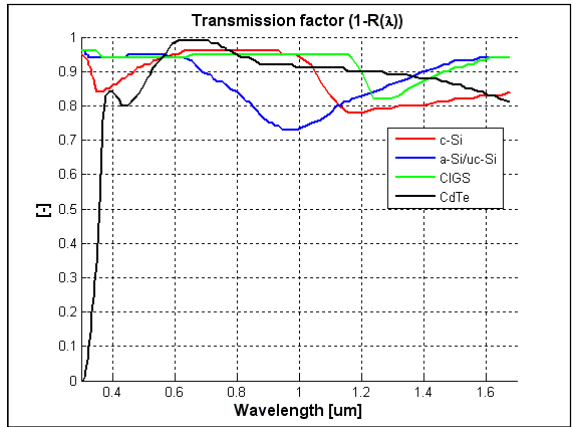
Figure 3. Transmittance factors .